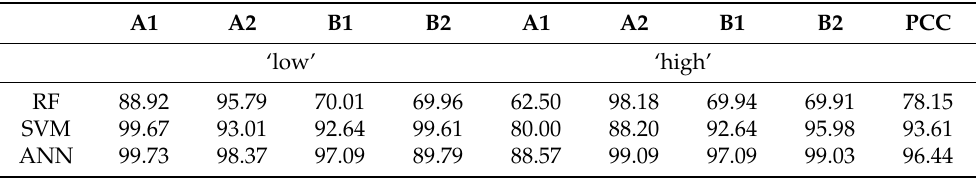
Table 8. Summary of the classification percentages for each dataset and class labels; CCP value for each classification algorithm, expressed as a percentage